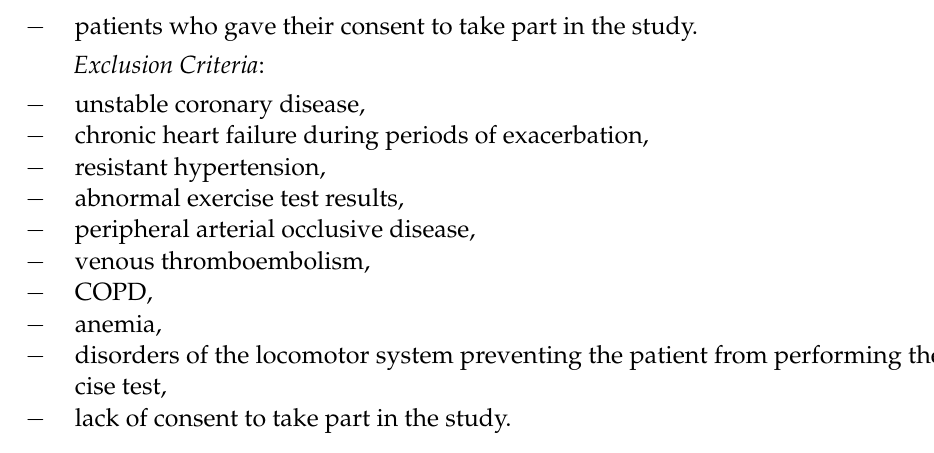
Table 1. Location of atherosclerotic lesions.